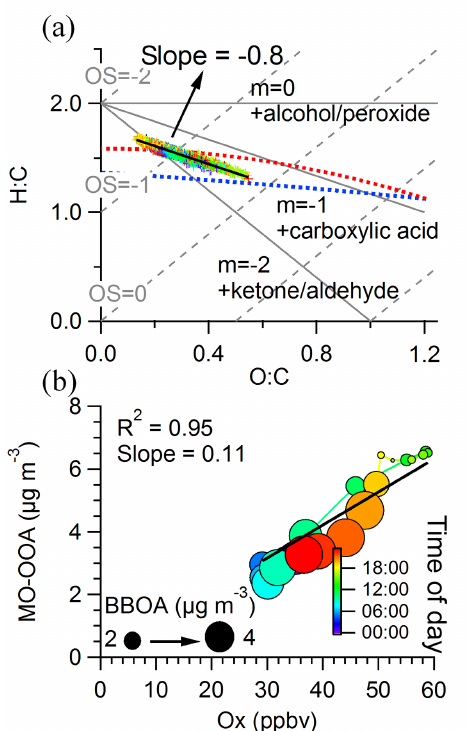
Figure 14. (a) Van Krevelen diagram for OA and (b) scatterplot of MO-OOA vs. O x (the sum of O 3 and NO 2 ) with linear fit and colored by time of